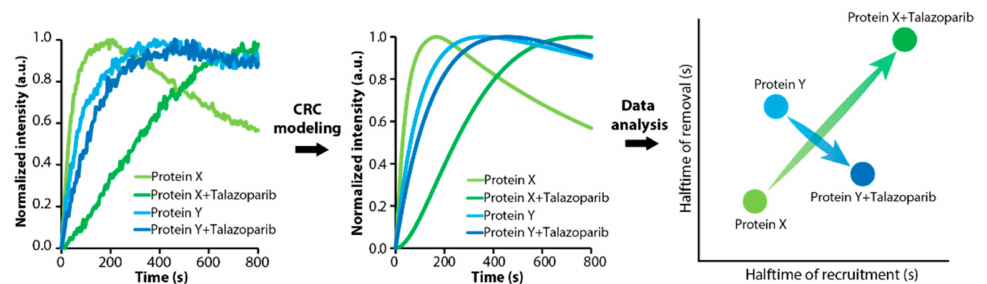
Figure 4. DNArepairK provides a comprehensive overview of the effects of talazoparib onto the dynamics of the DNA damage response. A comprehensive kinetics-based overview of the effects of talazoparib onto the dynamics of the DNA damage response can be obtained by measuring, CRC modeling, and comparing the kinetics of recruitment and removal of multiple DNA repair proteins in non-treated and talazoparib-treated